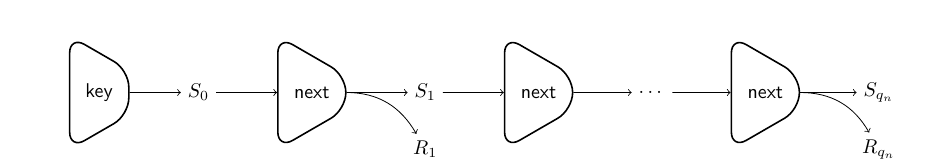
Figure 2: Stateful Pseudo-Random Number Generator [BY03]